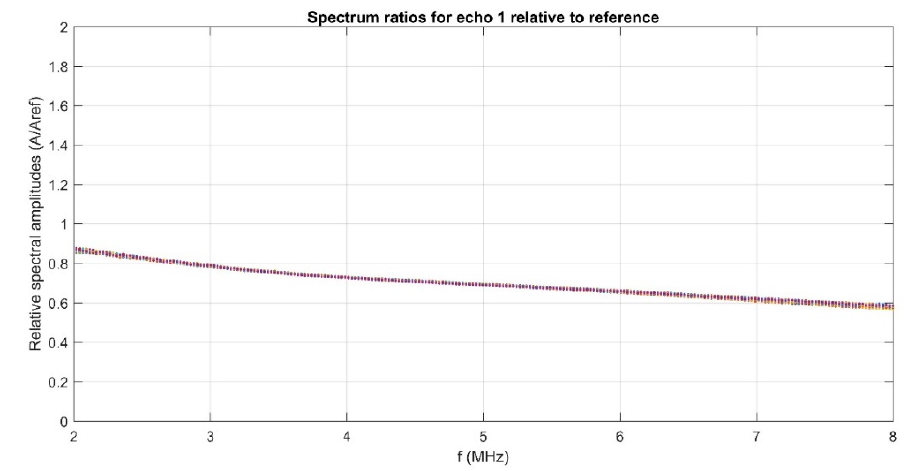
Figure 6. Spectral attenuation of the first echo and reference fluid.